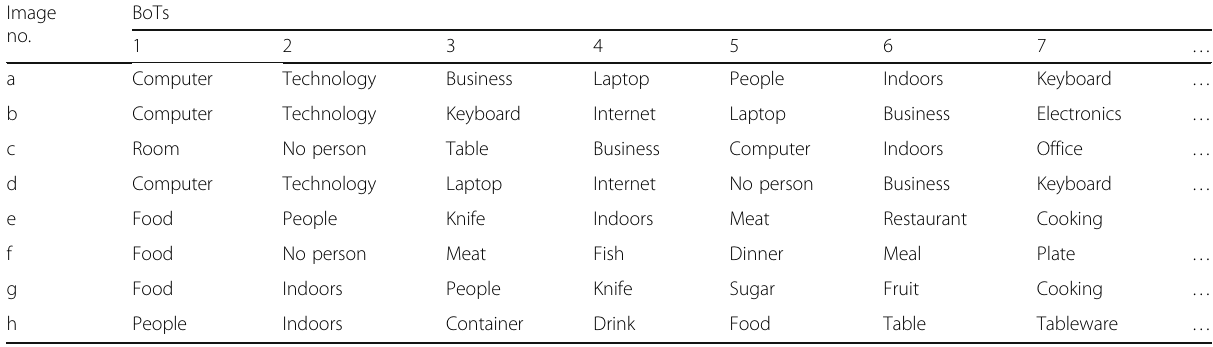
Table 3 BoTs produced by ClarifaiNet for the egocentric images in Fig. 3 Image